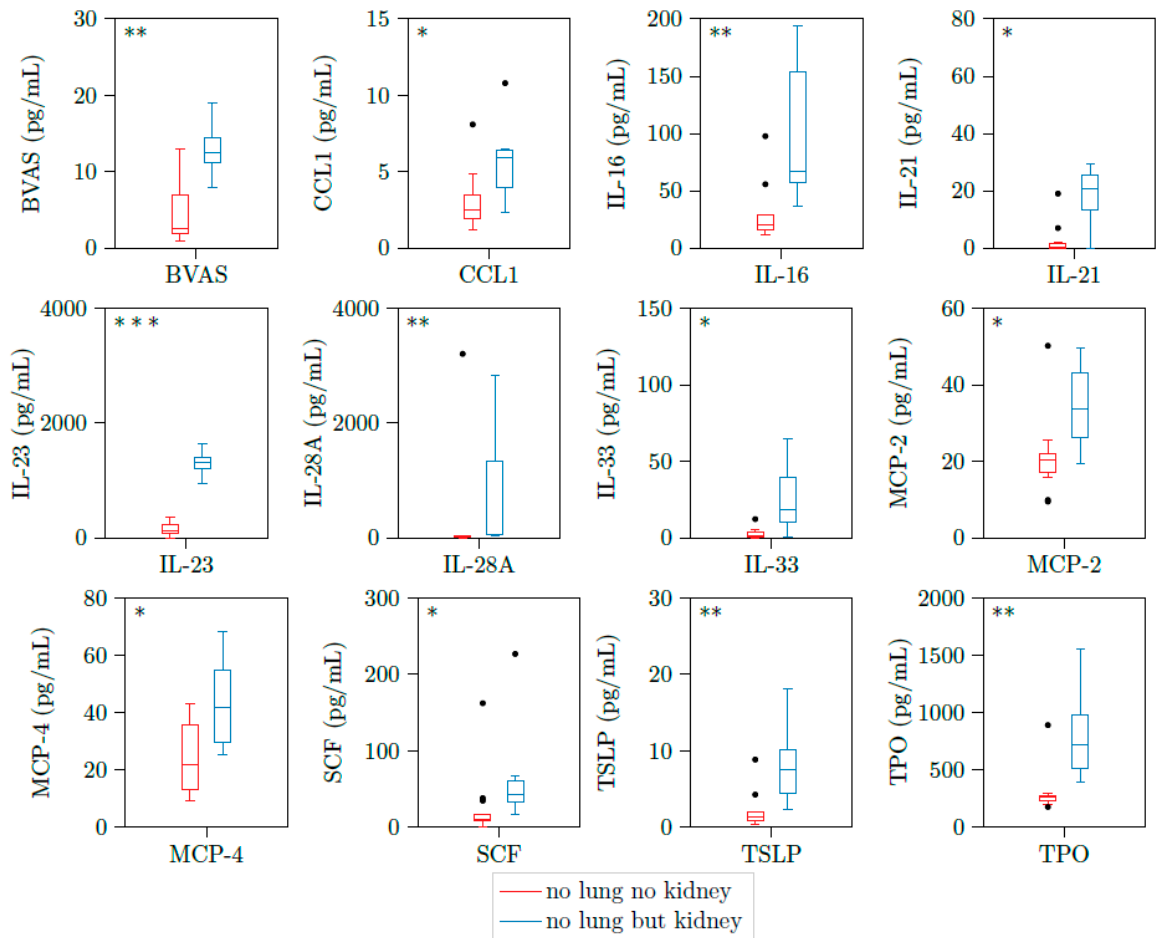
Figure 5. BVAS, CCL1, IL-16, IL-21, IL-23, IL-28A, IL-33, MCP2, MCP4, SCF, TSLP, and TPO are upregulated in patients with active AAV with both lung involvement and kidney involvement. Illustration of BVAS, CCL1, IL-16, IL-21, IL-23, IL28-A, IL-33, MCP2, MCP4, SCF, TSLP, and TPO plasma concentrations of 18 samples with active PR3-AAV and joint involvement. All cytokines were significantly elevated in patients with additional kidney involvement versus those without kidney involvement. * p < 0.05; ** p < 0.01, *** p < 0.001, boxes and whisker plots present distribution of the median, the upper and lower quartile, the whiskers with 1.5 of the interquartile distances, as well as the outliers.